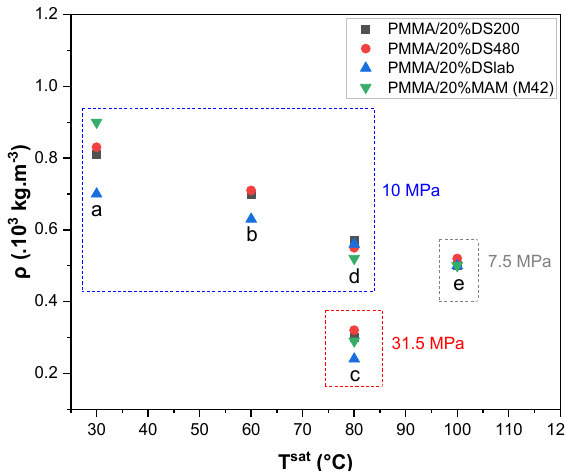
Figure 3. Evolution of foams density, one-step batch-foamed with scCO 2 various saturation temperature and pressure. Pressure is indicated with a frame and each group of points is marked with a letter also shown in Table 4.